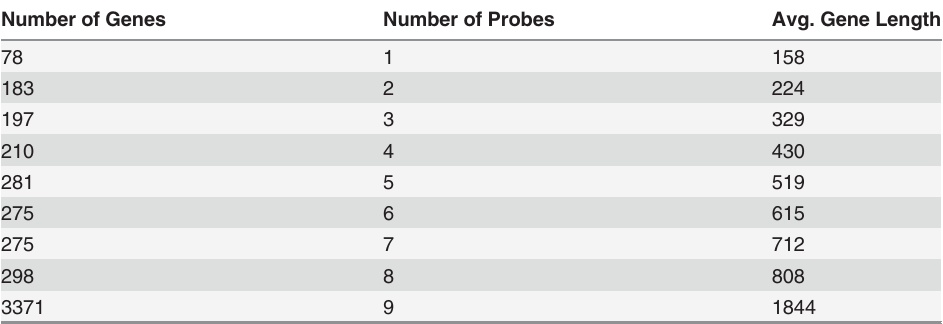
Table 1. The number of unique probes on the micro-array per gene. Number of